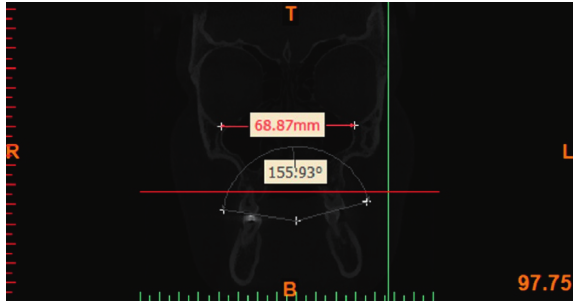
Figure 6: Measuring the curve of Wilson.